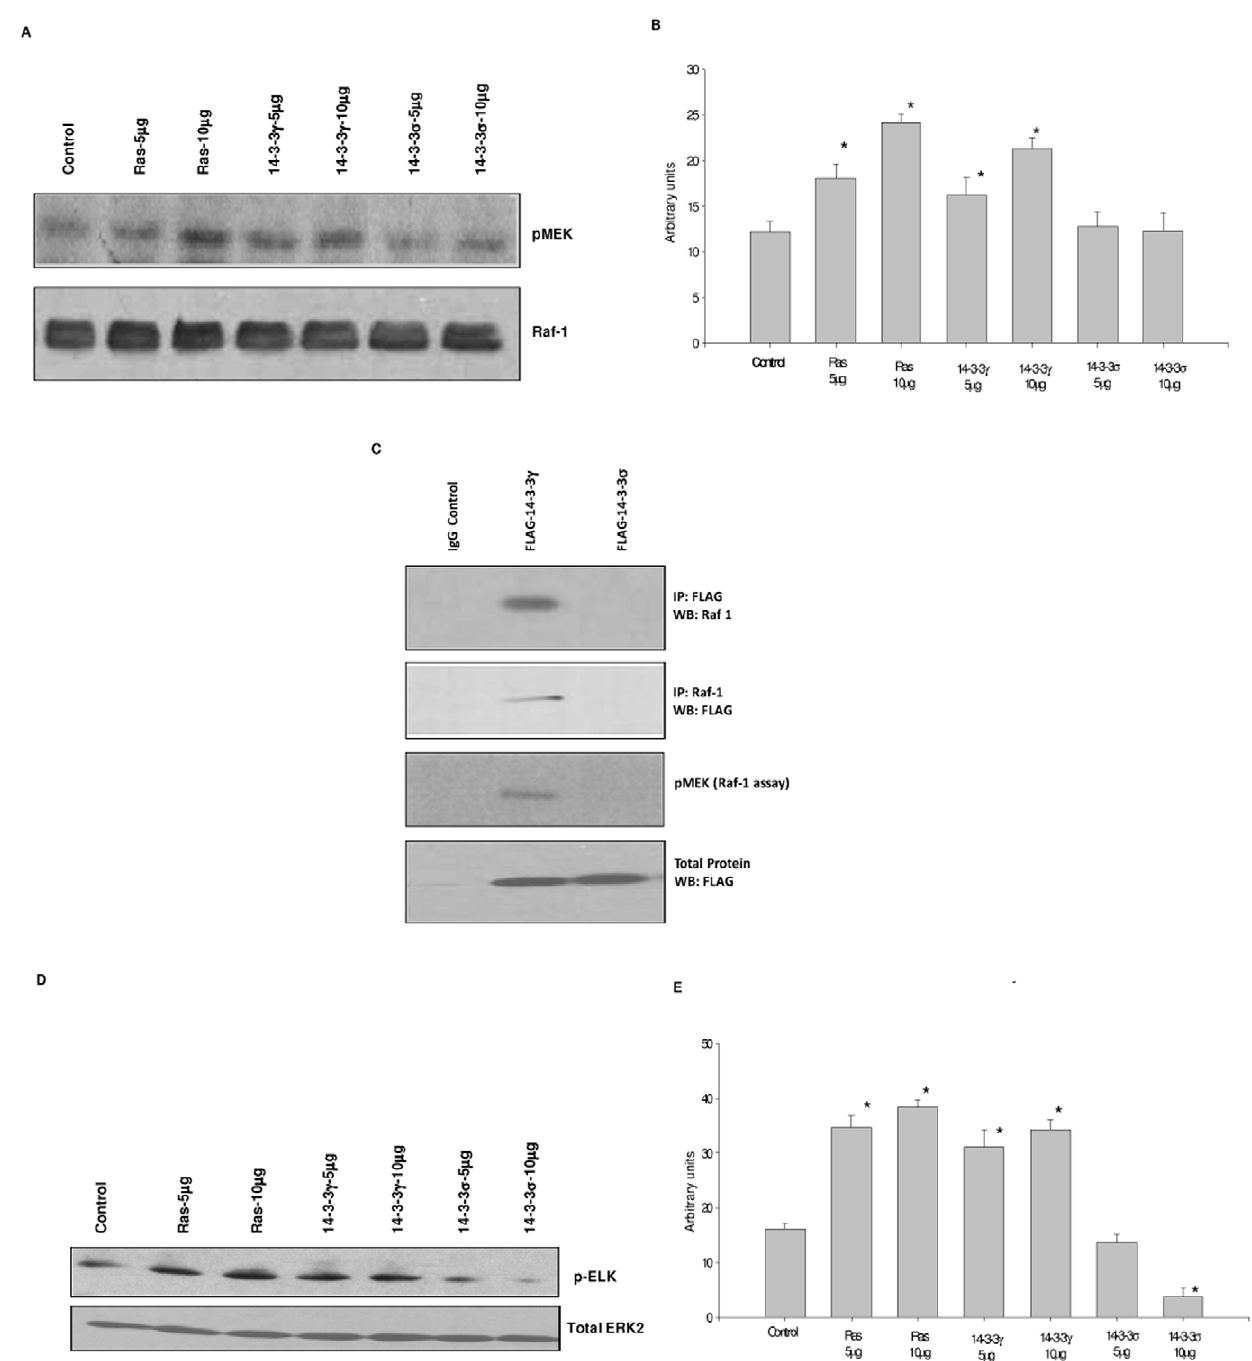
Figure 4. 14-3-3 c activates MAPK signaling. (A) Increasing quantities of H-ras, 14-3-3 c , 14-3-3 s , expression plasmids or vector only (control) were transiently transfected into NIH3T3 cells. Forty eight hours after transfection, the cells were serum starved overnight, harvested, and cell extracts examined for Raf-1 activity by incubating with recombinant MEK protein in the presence of [ c - 32 P] ATP. Total raf-1 protein in the extracts was determined by immunoblotting (bottom panel). The experiment was repeated three times. A typical experiment is depicted. (B) The amount of radioactivity in the pMEK bands in panel A was quantified. Bars in the graph are the average for the three experiments. Error bars depict standard deviation (*, p , 0.05 vs. vector control). (C) Extracts were prepared from NIH3T3 cells stably transfected with FLAG-14-3-3 c or FLAG-14-3-3 s . 14-3-3 proteins were immunoprecipitated with anti-FLAG antibody and the precipitated proteins tested for the presence of raf-1 by immunoblotting (top panel). Raf-1 protein was immunoprecipitated from the same extracts and tested for the presence of 14-3-3 proteins using the anti-FLAG antibody (second panel). The extracts were also tested for raf-1 kinase activity as described above (third panel). Total 14-3-3 protein was detected in the extracts by immunoblotting using the anti-FLAG antibody (bottom panel). (D) NIH3T3 cells were transiently transfected with increasing quantities of H-ras, 14-3-3 c , or 14-3-3 s expression plasmids as indicated. Forty eight hours later the cells were harvested, extracts prepared and ERK2 activity determined by incubating with recombinant Elk-1 protein and phosphorylated ELK detected by immunoblotting using an anti-phosphorylated-ELK antibody. Total ERK2 protein was detected by immunoblotting using an anti-ERK2 antibody (bottom panel). The experiment was repeated three